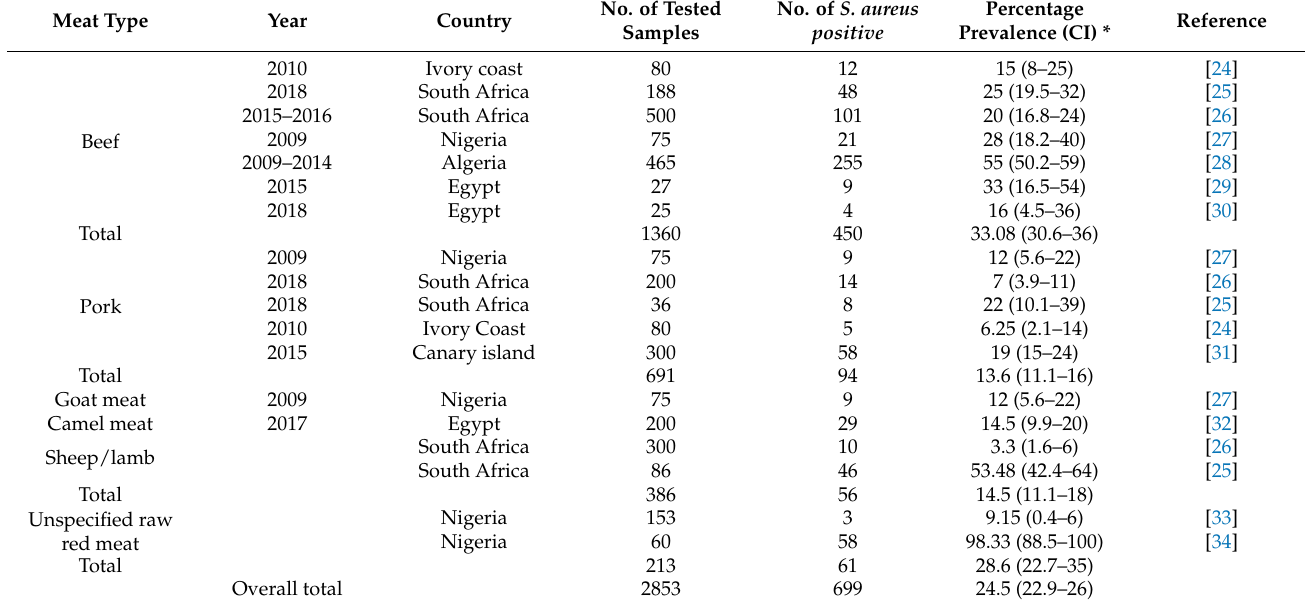
Table 1. Prevalence of S. aureus (non-MRSA) in raw unprocessed red meat in African countries. Meat